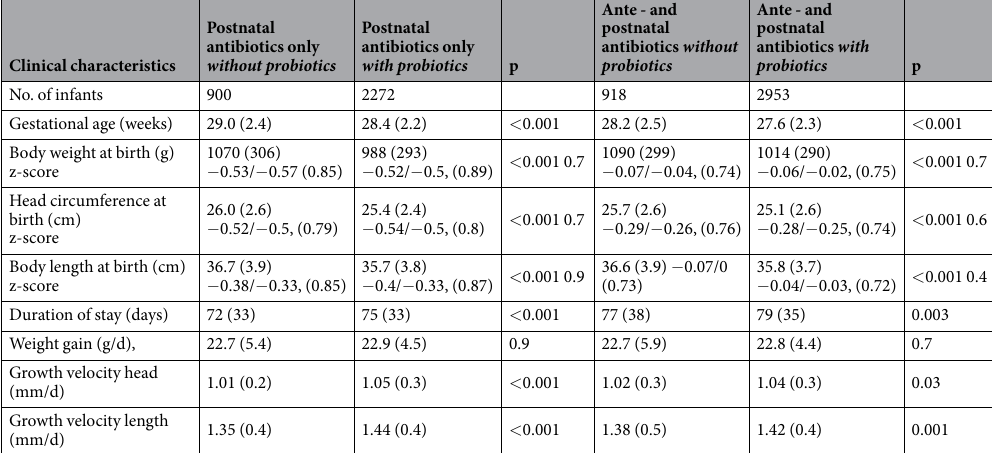
Table 5. Postnatal antibiotics and effect probiotics. Legend: Continuous variables are shown as mean (SD); z-scores are shown as mean/median (SD). Categorical variables are shown as percent. p-values were derived from Fisher’s exact test or Mann-Whitney-U test if indicated ( * ), SGA, small for gestational age ( < 10th percentile of birth weight adjusted to gestational age). Growth velocity and weight gain were calculated by differences between parameters at birth and respective measures at discharge/number of days (duration of